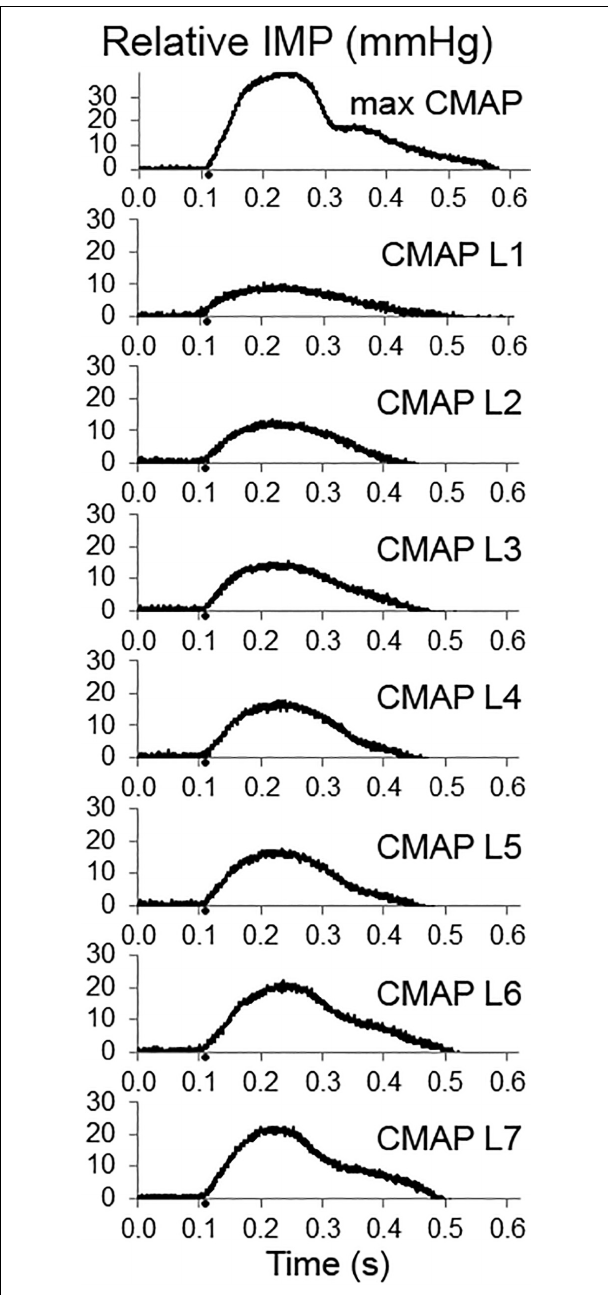
FIGURE 2 | Examples of intramuscular pressure (IMP) responses to the increasing levels of fibular nerve stimulation up to obtaining a maximum compound muscle action potential (CMAP) (upper panel). The IMP responses associated with increasing CMAP amplitude are shown as CMAP level 1 (CMAP L1), CMAP L2, CMAP L3, CMAP L4, CMAP L5, CMAP L6, and CMAP L7, respectively.